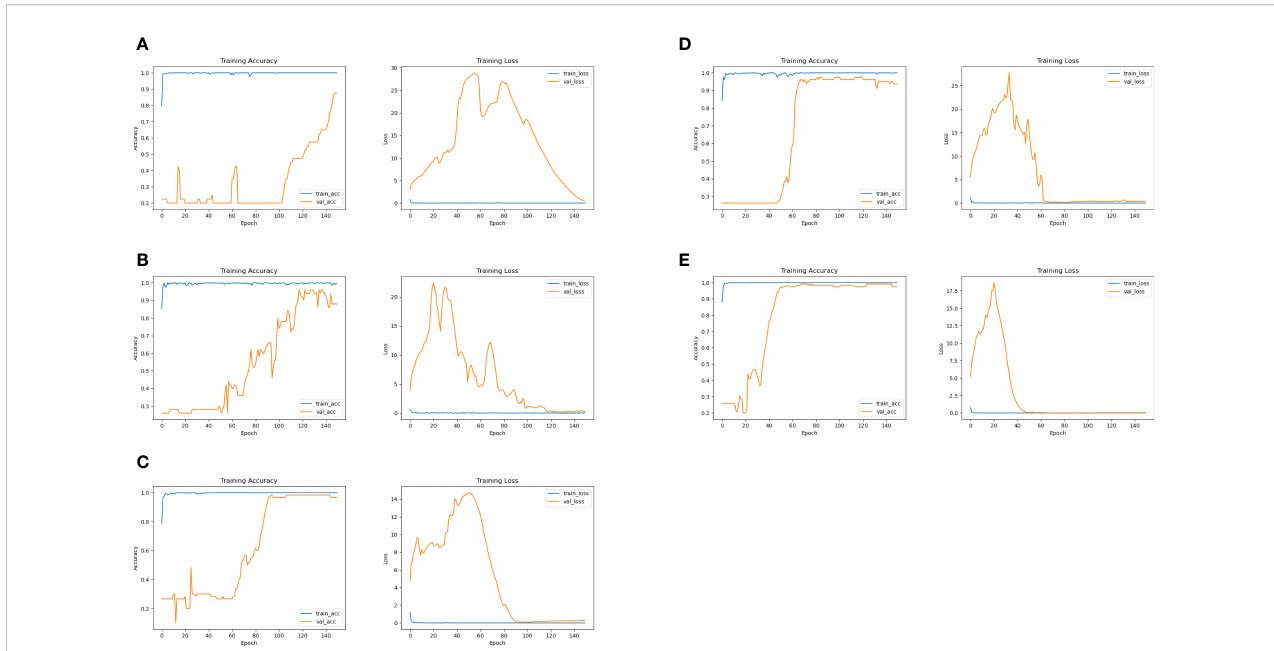
FIGURE 11 ResNet classi fi cation results. (A) Results of ResNet on the original dataset. (B) Results of ResNet at 4:1 dataset. (C) Results of ResNet at 2:1 dataset. (D) Results of ResNet at 1:1 dataset. (E) Results of ResNet at 1:2 dataset.